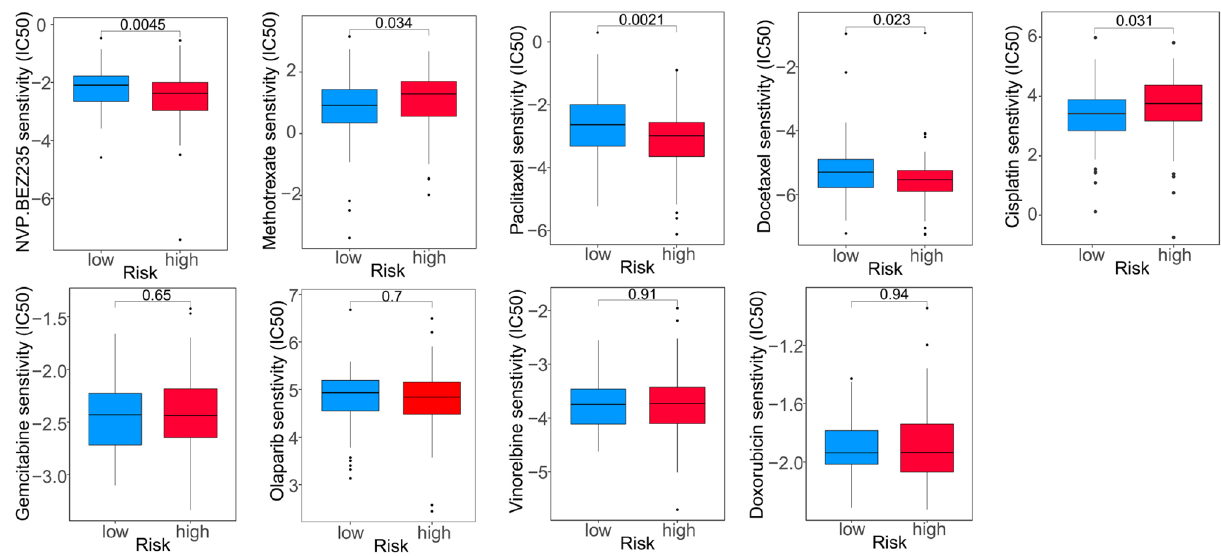
Figure 10. Evaluation of chemosensitivity by the risk